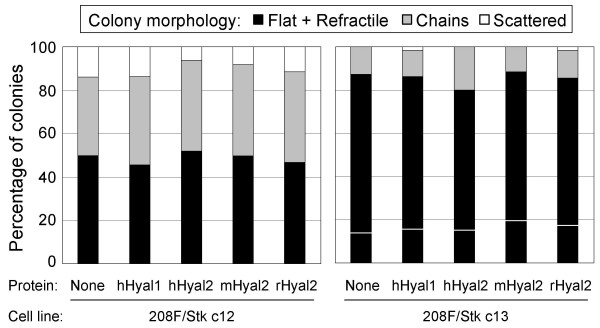
Colony morphology of 208F/Stk cells is unaffected by Hyal2 expression. 208F/Stk c12 and c13 cells were transduced with retrovirus vectors expressing the indicated proteins or were not transduced (None), the cells were seeded at low density, and colony morphologies were evaluated 1 week after seeding. In the right panel, the numbers of flat (bottom black bar) and refractile (top black bar) colonies were counted separately. In the left panel these categories were combined. The experiment was repeated with similar results.